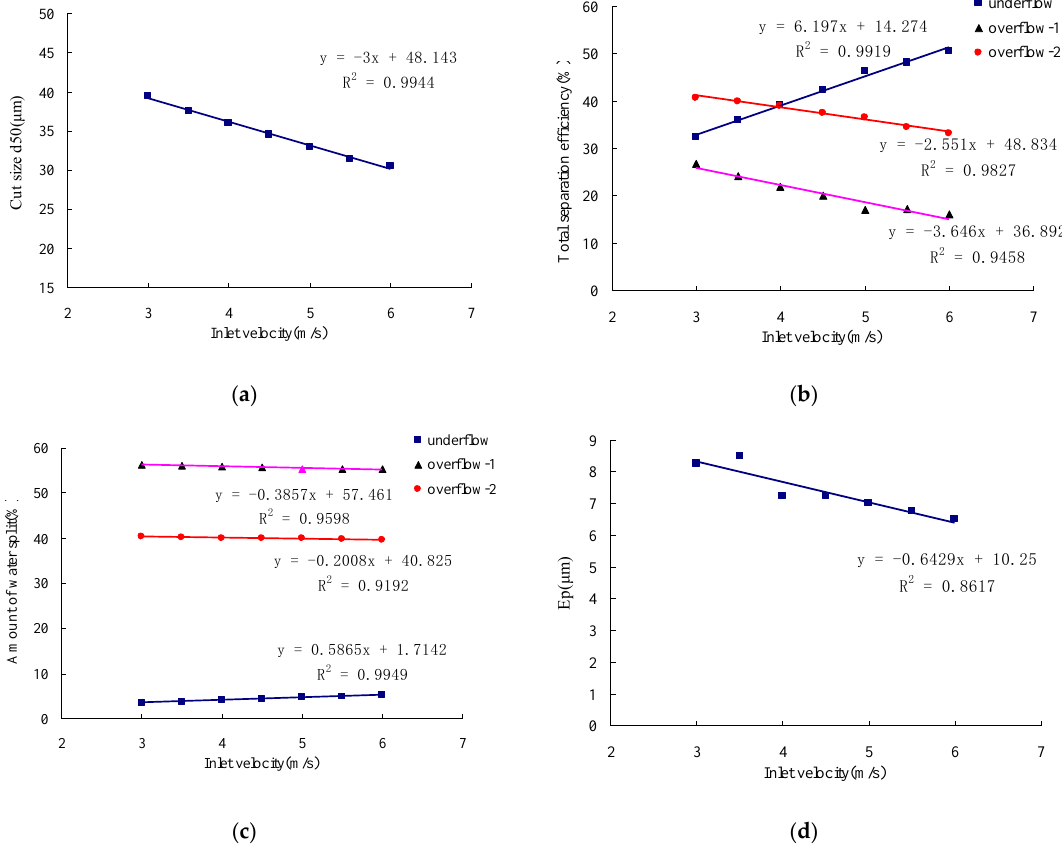
Figure 11. Comparison of separation performance: ( a ) cut size d 50 ; ( b ) total separation efficiency; ( c ) split ratio; ( d ) E p.